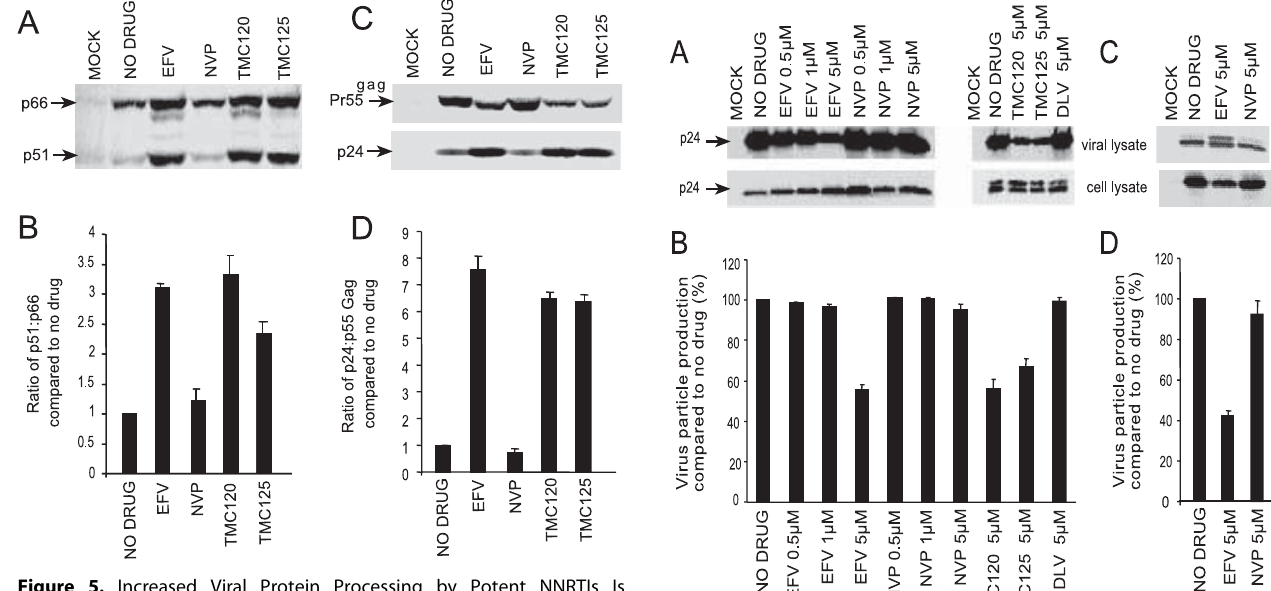
Figure 5. Increased Viral Protein Processing by Potent NNRTIs Is Independent of Gag/GagPol Localization to the Plasma Membrane Cells were treated as described in Figure 3, except for transfection with pGA2-NL4.3, which expresses a myr(-) defective mutant of HIV-1. All drugs were tested at 5 l M. Cell lysates harvested after 36 h were analyzed by quantitative Western blotting using (A) anti-RT and (C) anti- CA. Quantitation of the ratio of (B) p51 to p66 and (D) p24 to Pr55 gag from Western blots was performed using the Odyssey system. The ratios were calculated from at least three independent experiments and are expressed as the mean 6 standard